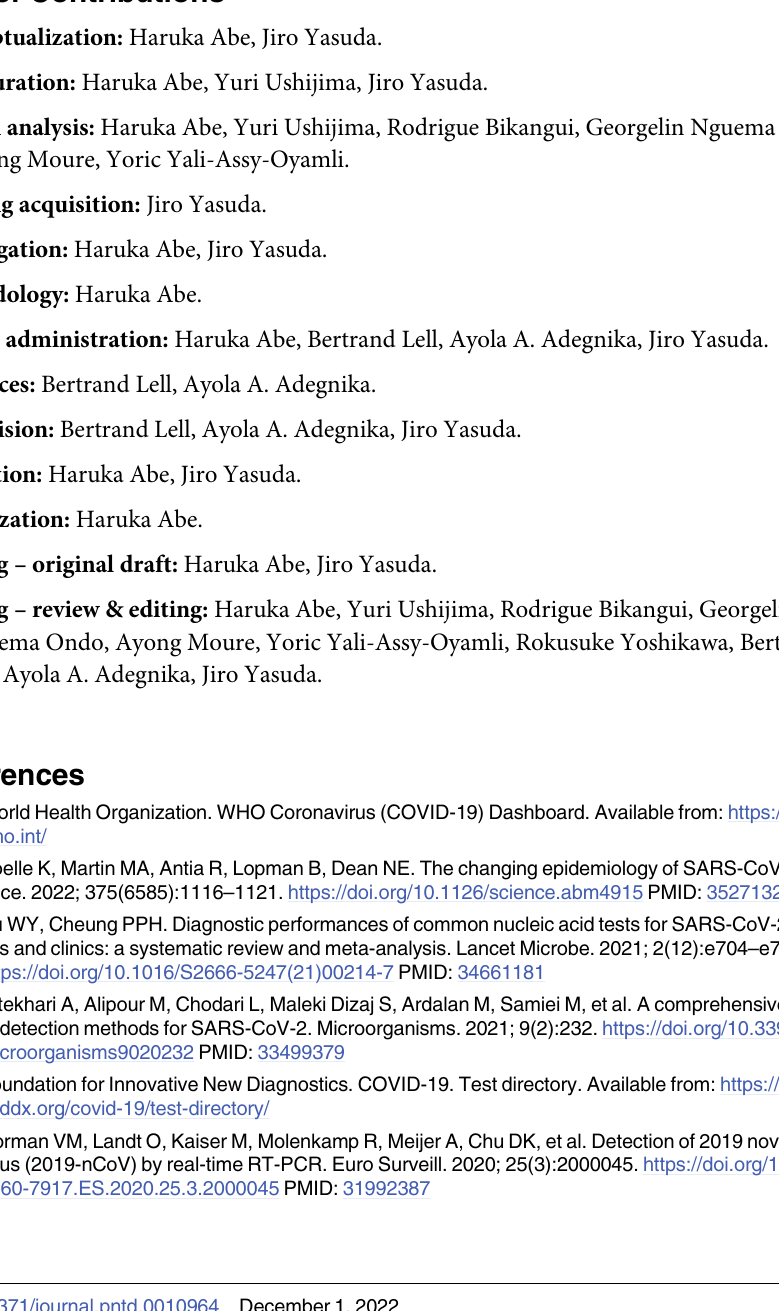
S2 Table. Evaluation of the sensitivity of RT-LAMP assay using viral RNA of SARS-CoV-2